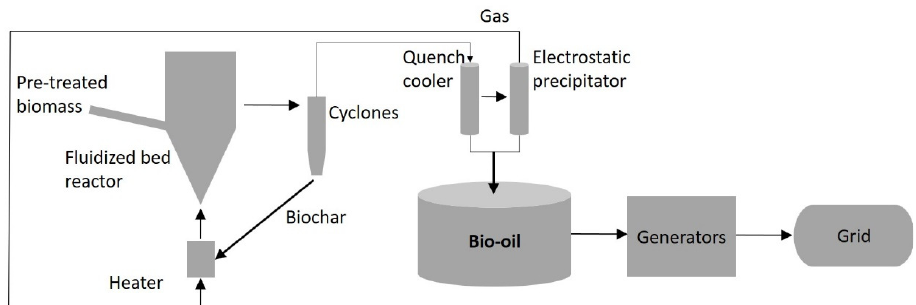
Figure 4. The process for converting pre-treated biomass into bio-oil, then injected into diesel generators and electricity exported to the microgrid network.